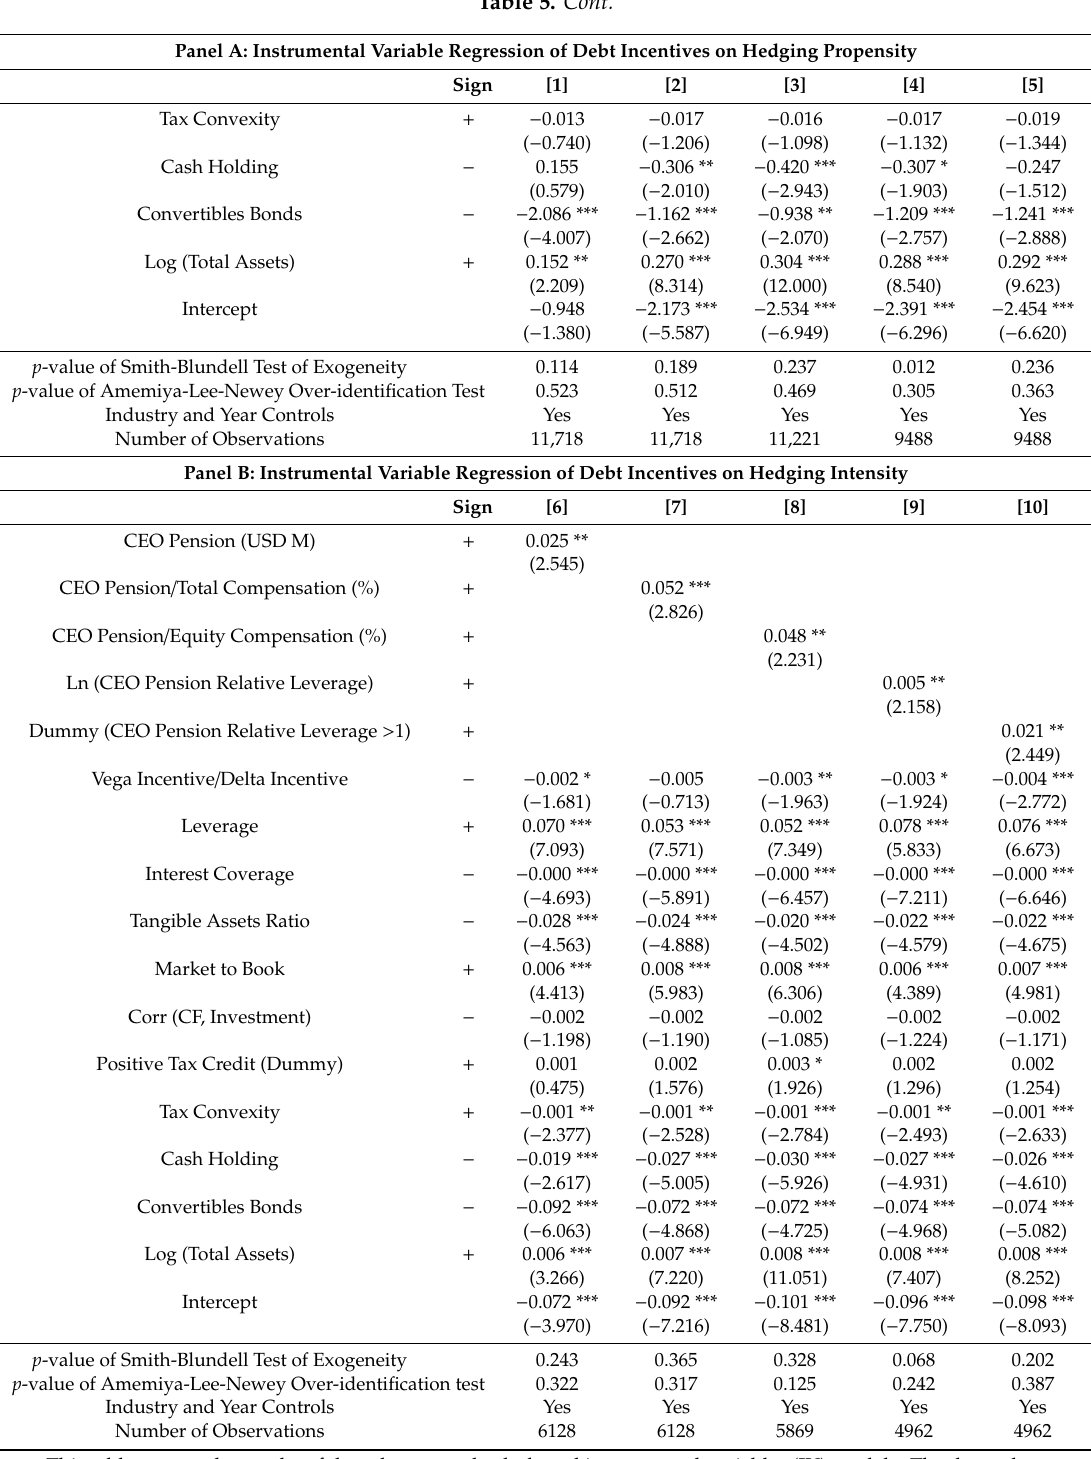
Panel A: Instrumental Variable Regression of Debt Incentives on Hedging